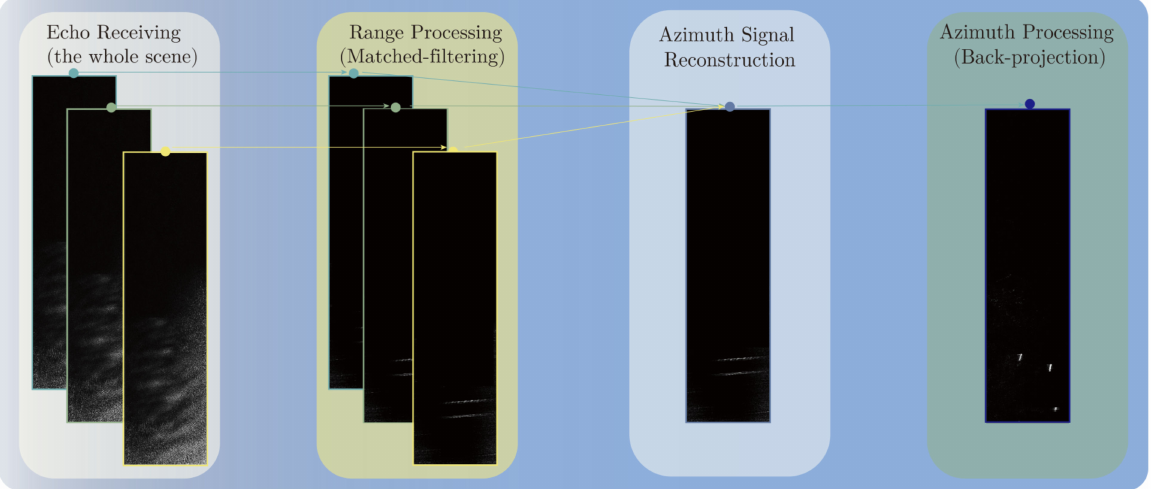
Figure 3. Current imaging framework for HRWS imaging.